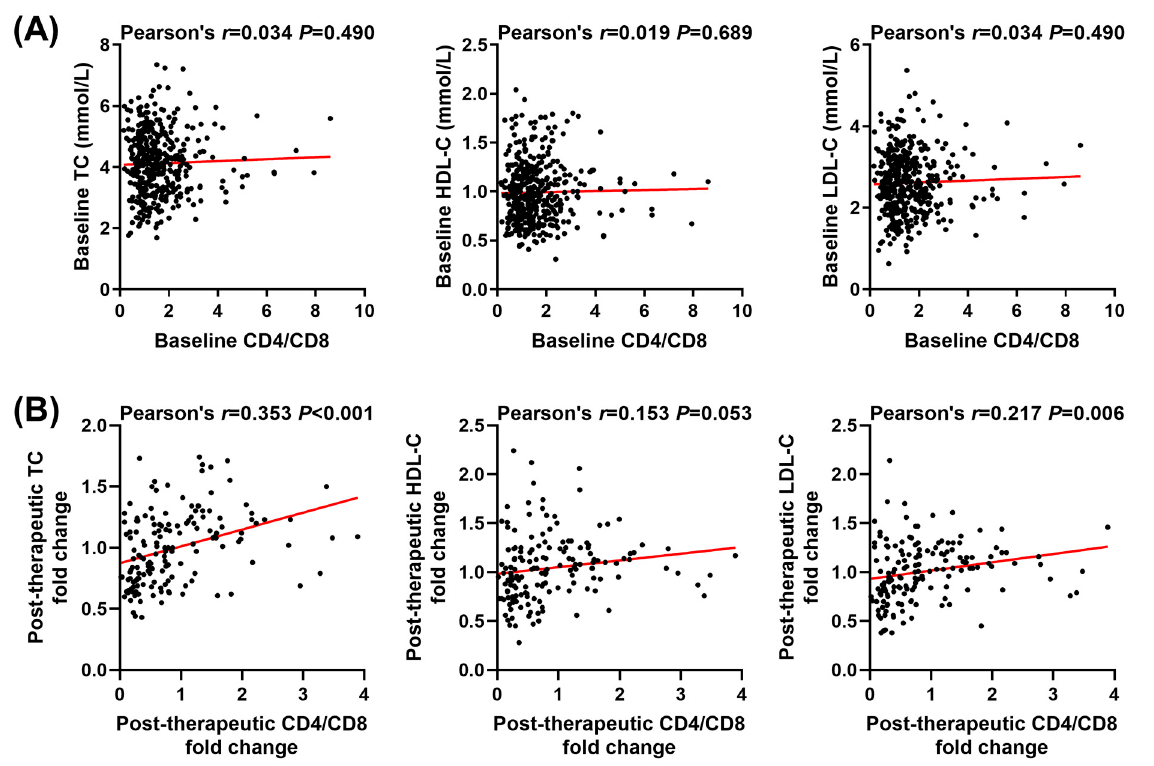
Figure 4. T cell subset counts in relation to cholesterol levels. ( A ) Correlation between baseline CD4/CD8 ratio and total cholesterol (TC), high-density lipoprotein cholesterol (HDL-C), and low- density lipoprotein cholesterol (LDL-C) levels; ( B ) Correlation between post-therapeutic fold change of CD4/CD8 ratio and fold change of TC, HDL-C, and LDL-C.